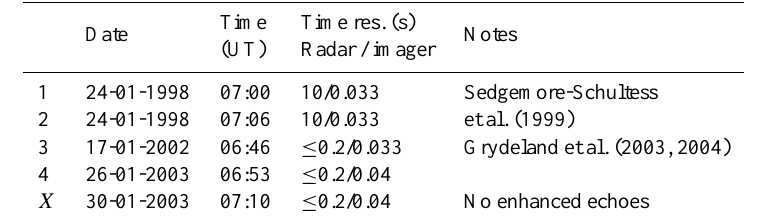
Table 1. List of